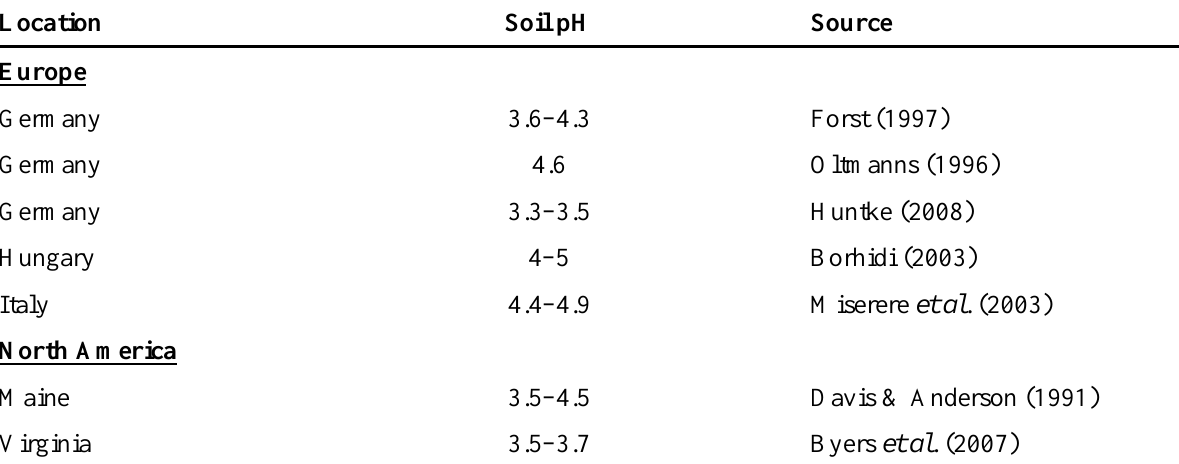
Table 1. pH values for wetland soils with Drosera rotundifolia in central Europe and North America.